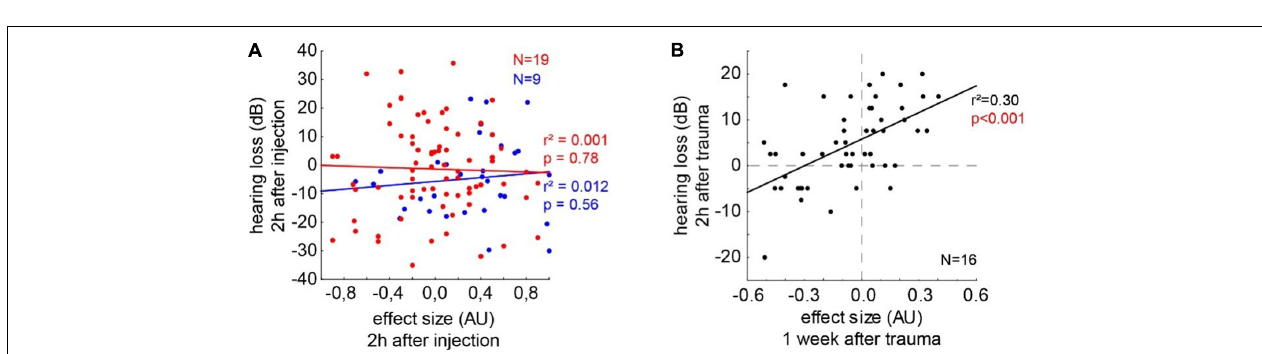
FIGURE 7 | Analyses of hearing loss (A) and GPIAS effect size (B) in 16 animals after an acoustic noise trauma centered around 2 kHz. The animals are separated into those with behavioral signs of tinnitus (T, n = 10, red symbols) and those without such behavioral indications (NT, n = 6, blue symbols). Given are the results of the two-factorial ANOVAs with factors animal group and stimulation frequency . Both analyses show a peak effect at 4 kHz. Asterisks indicate significant Tukey post hoc tests: * p < 0.05, ** p < 0.01.